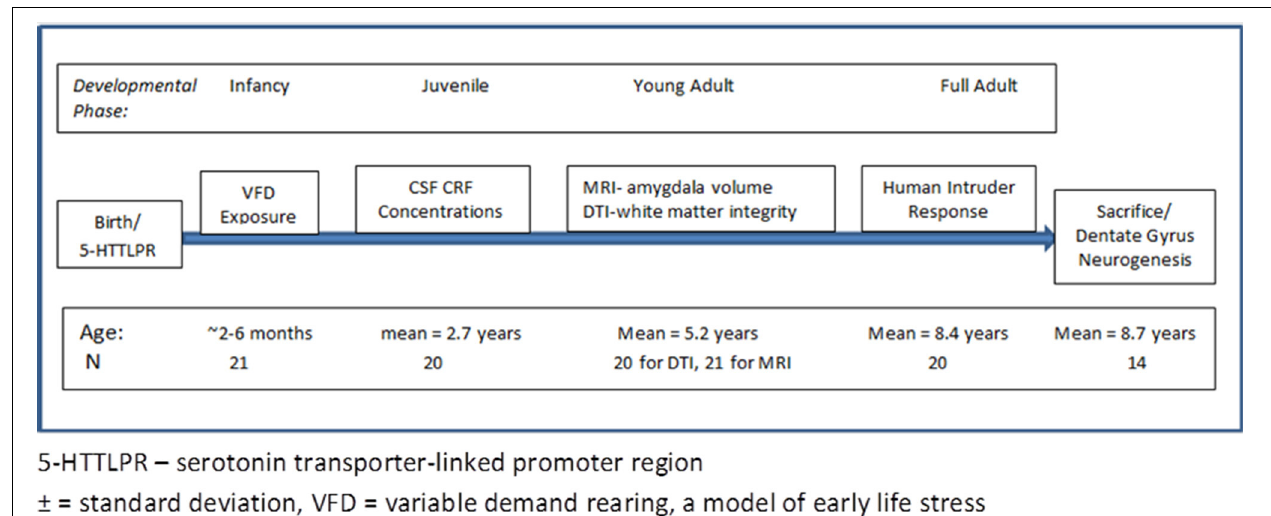
FIGURE 1 | Time line and experimental procedure of the study. The figure outlines the time line of the developmental phase of the bonnet macaque male subjects and at which point interventions were performed. The bottom row provides the age of the subjects at the time of the experimental